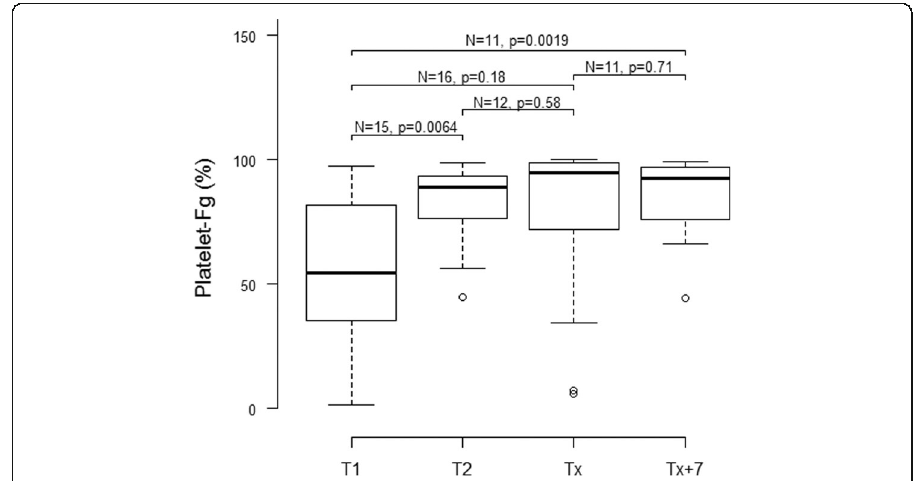
Fig. 1 Serial measurements of levels of platelet-bound fibrinogen (platelet-Fg) for patients who developed sepsis. Platelet-Fg levels were analyzed by flow cytometry on the day of ICU admission ( T1 ), after 48 h ( T2 ), at the time of sepsis diagnosis ( Tx ), and 7 days later ( Tx + 7 ). Median values of percentages of Fg-positive platelets and IQR are shown ( P value: Kruskal-Wallis